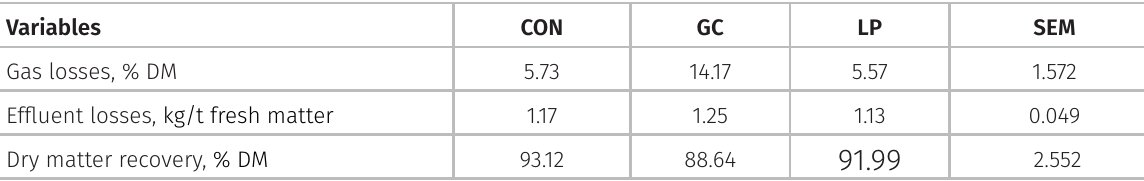
-N, mg/dL) of pearl millet silage. 3